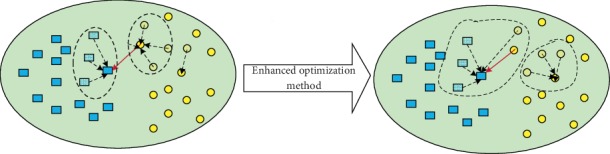
Case (i): xα is an exemplar.